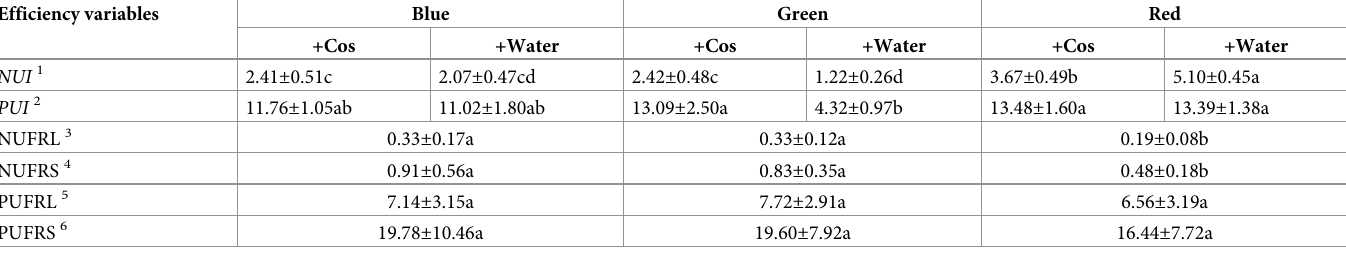
Table 5. Assessments of uptakes and utilizations in nitrogen (N) and phosphorus (P) nutrients in Podocarpus macrophyllus seedlings in response to combined spec- tra (Blue, Green, and Red) and chitosan and water sprays (+Cos vs +Water) ( n = 6). Efficiency